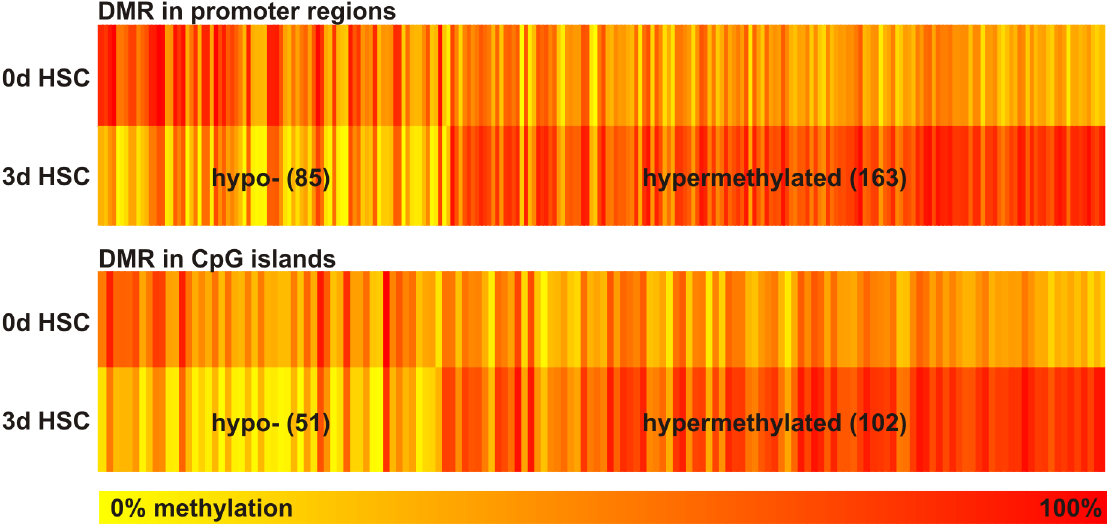
Fig 2. Heat map of identified differentially methylated regions (DMRs) within promoter regions or CpG islands. Only DMRs with a methylation difference of at least 20% between freshly isolated (0d) and early activated (3d) HSC and p < 0.05 are displayed as a heat map. The gradual color from yellow (0%) to red (100%) indicated the level of DNA methylation according to EpiQuest sequencing. The number of DMRs was stated in brackets. There were more hypermethylated as demethylated regions identified during early HSC